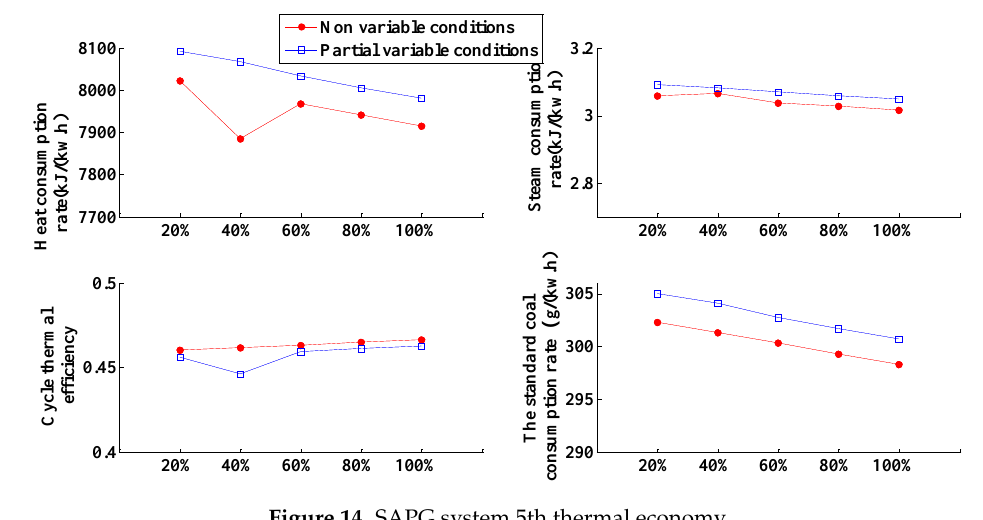
Figure 13. SAPG system 4th thermal economy.